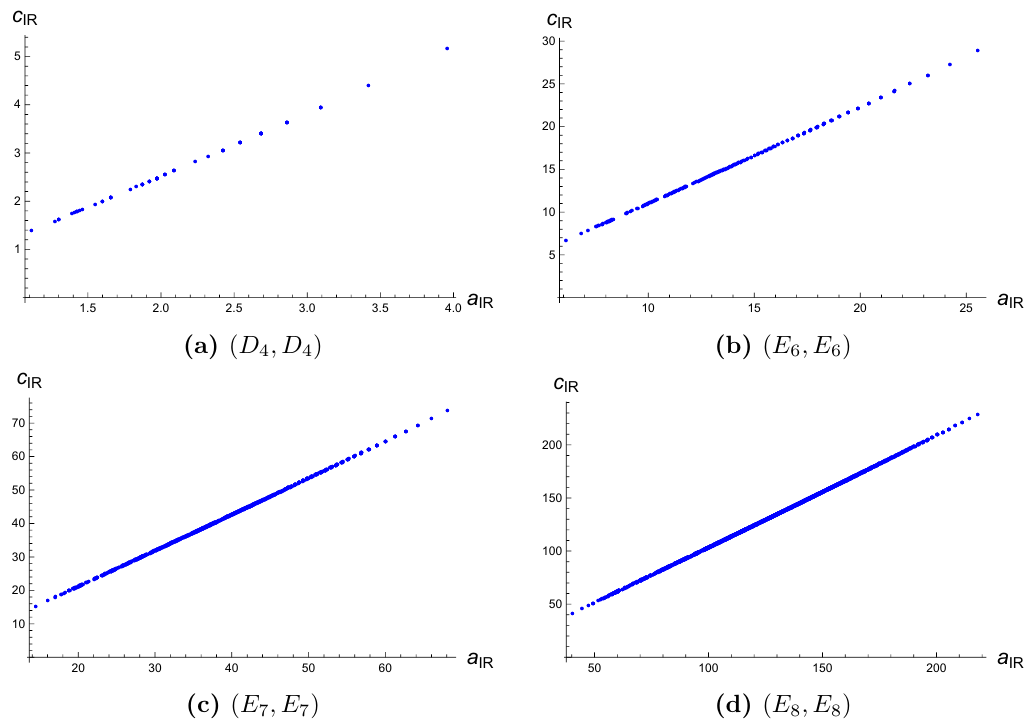
Figure 9. Plots of c IR vs a IR for the di(cid:11)erent plain mass nilpotent deformations of 4D conformal matter